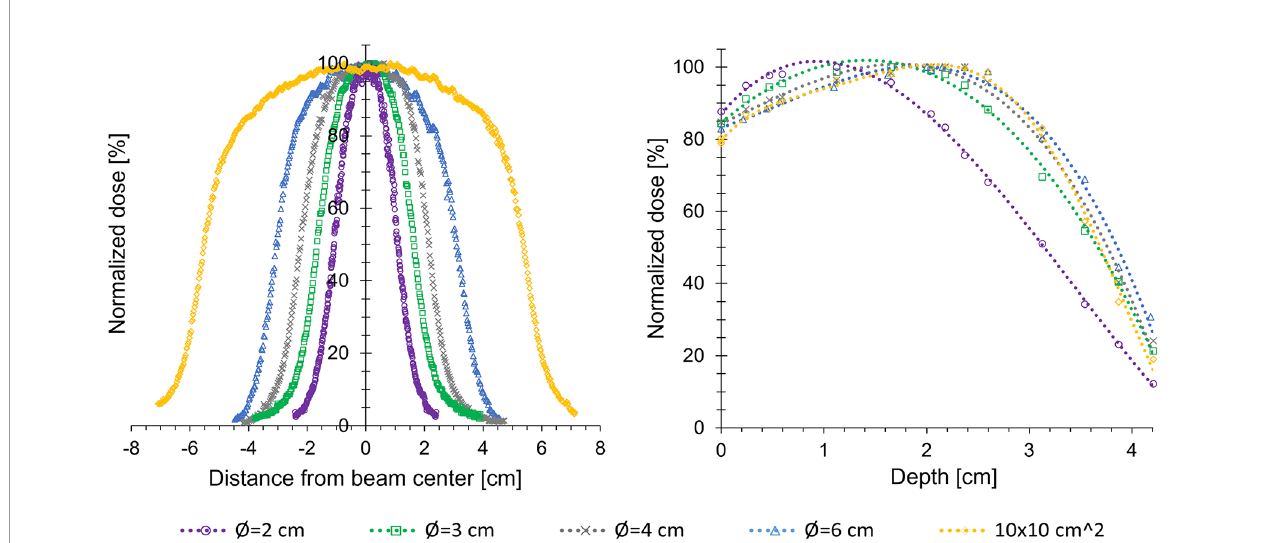
FIGURE 3 | Dose pro fi les at 2 cm (left panel) and percentage depth dose curves (right panel) measured in a solid water phantom, for various fi eld sizes of the Cerrobend plates fi tted in the electron applicator. The therapeutic range (R 80 -value) ranged from 2.3-3.2 cm, depending on fi eld